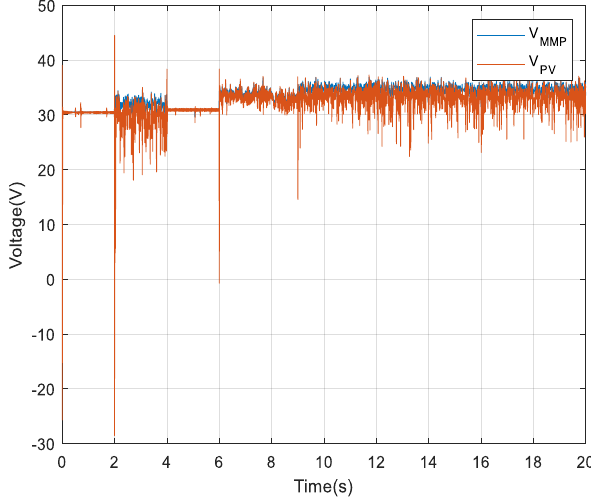
Figure 24. Temporal evolution of PV voltage over time.